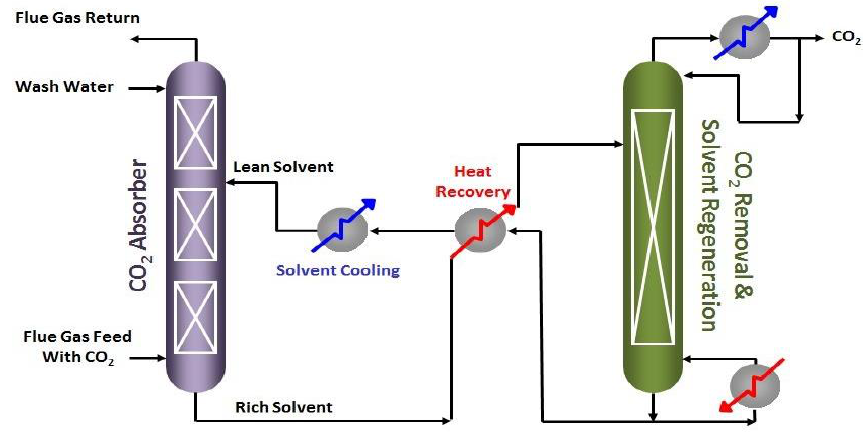
Figure 8. General process diagram for the amine treatment process.